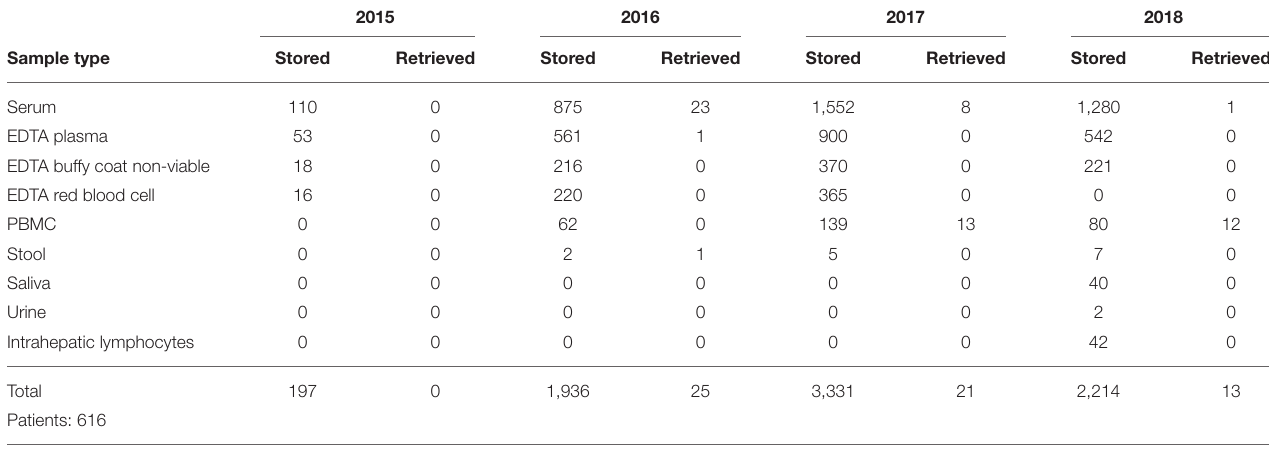
TABLE 1a | Hospital-based sampling (informed consent).